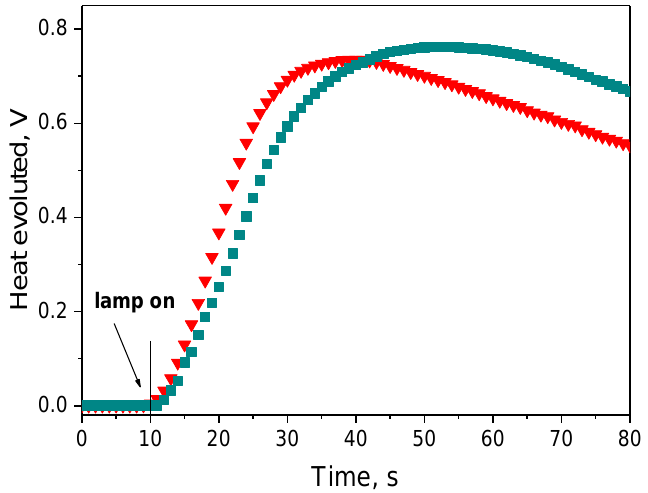
Figure 8. Comparison of the acrylate monomer polymerization initiated by either an electron transfer or hydrogen atom transfer mechanism. The tested photoinitiating systems possess the same light absorber, acenaphto[1,2-b]benzo[g]quinoxaline (AN6) and different co-initiator, i.e., an electron donor ▼ —diMPhTAA and a hydrogen atom donor ■ —MBX. The kinetic curves were recorded during the measurements of the heat flow emitted in the course of TMPTA polymeriza- tion. The co-initiator concentration was 0.1 M, optical density of the sensitizers was 1.8 at an exci- tation wavelength (400 nm), light intensity of dental lamp was 30 mW/cm 2